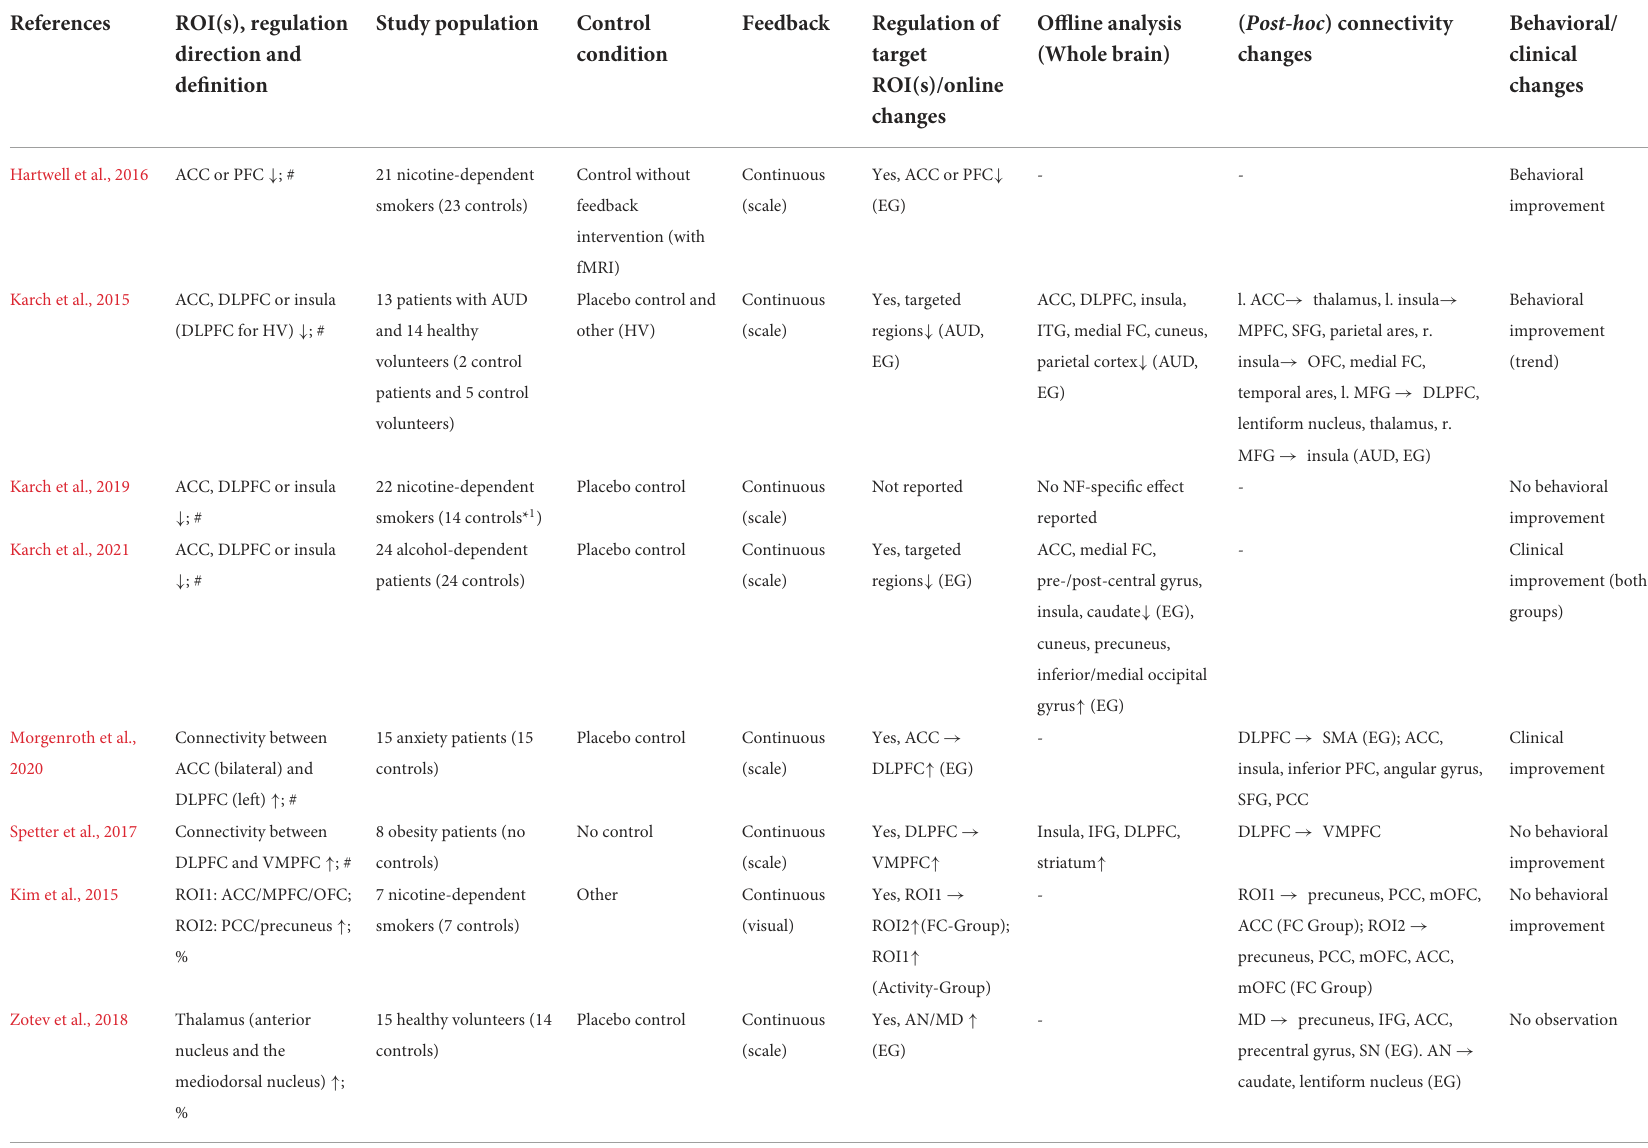
TABLE 4 Details of real-time fMRI neurofeedback studies with regulation target in mixed